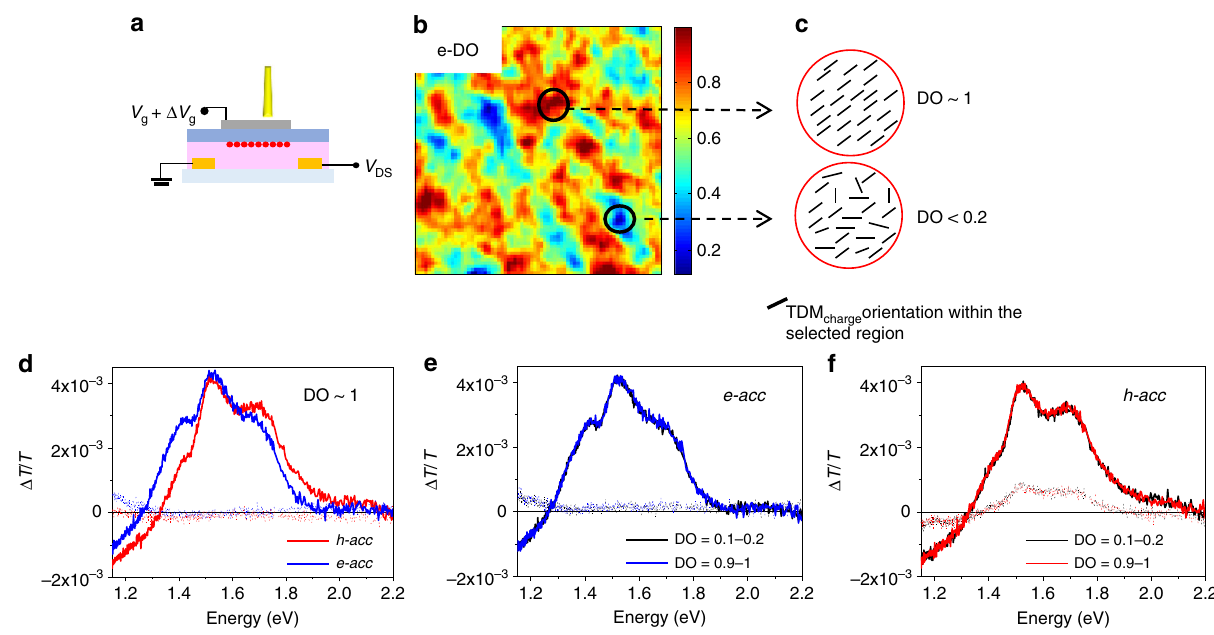
Fig. 5 Comparing local CMS spectra acquired in regions with DO ≈ 1 and DO < 0.2. Top panel: a scheme of the OFET device under local CMS light probe. b e-acc DO map (15 μ m ×15 μ m). c Schematics of charge transition dipole moment alignment (TDM): black circles indicate regions of DO ≈ 1 and DO < 0.2, whose TDM vector distribution is sketched in the drawing on the right side. d h-acc and e-acc spectra acquired in an area with DO ≈ 1. e e-acc local CMS spectra acquired in regions with, respectively, DO ≈ 1 and DO ≈ 0.2. f h-acc local CMS spectra acquired in the region with, respectively, DO ≈ 1 and DO ≈ 0.2 (OFET electron accumulation, e-acc : V g = 30 V; V pp = 40 ± 20 V; hole accumulation, h-acc : V g = − 30 V; V pp = 40 ± 20 V; dashed lines, out-of-phase signal; degree of order,